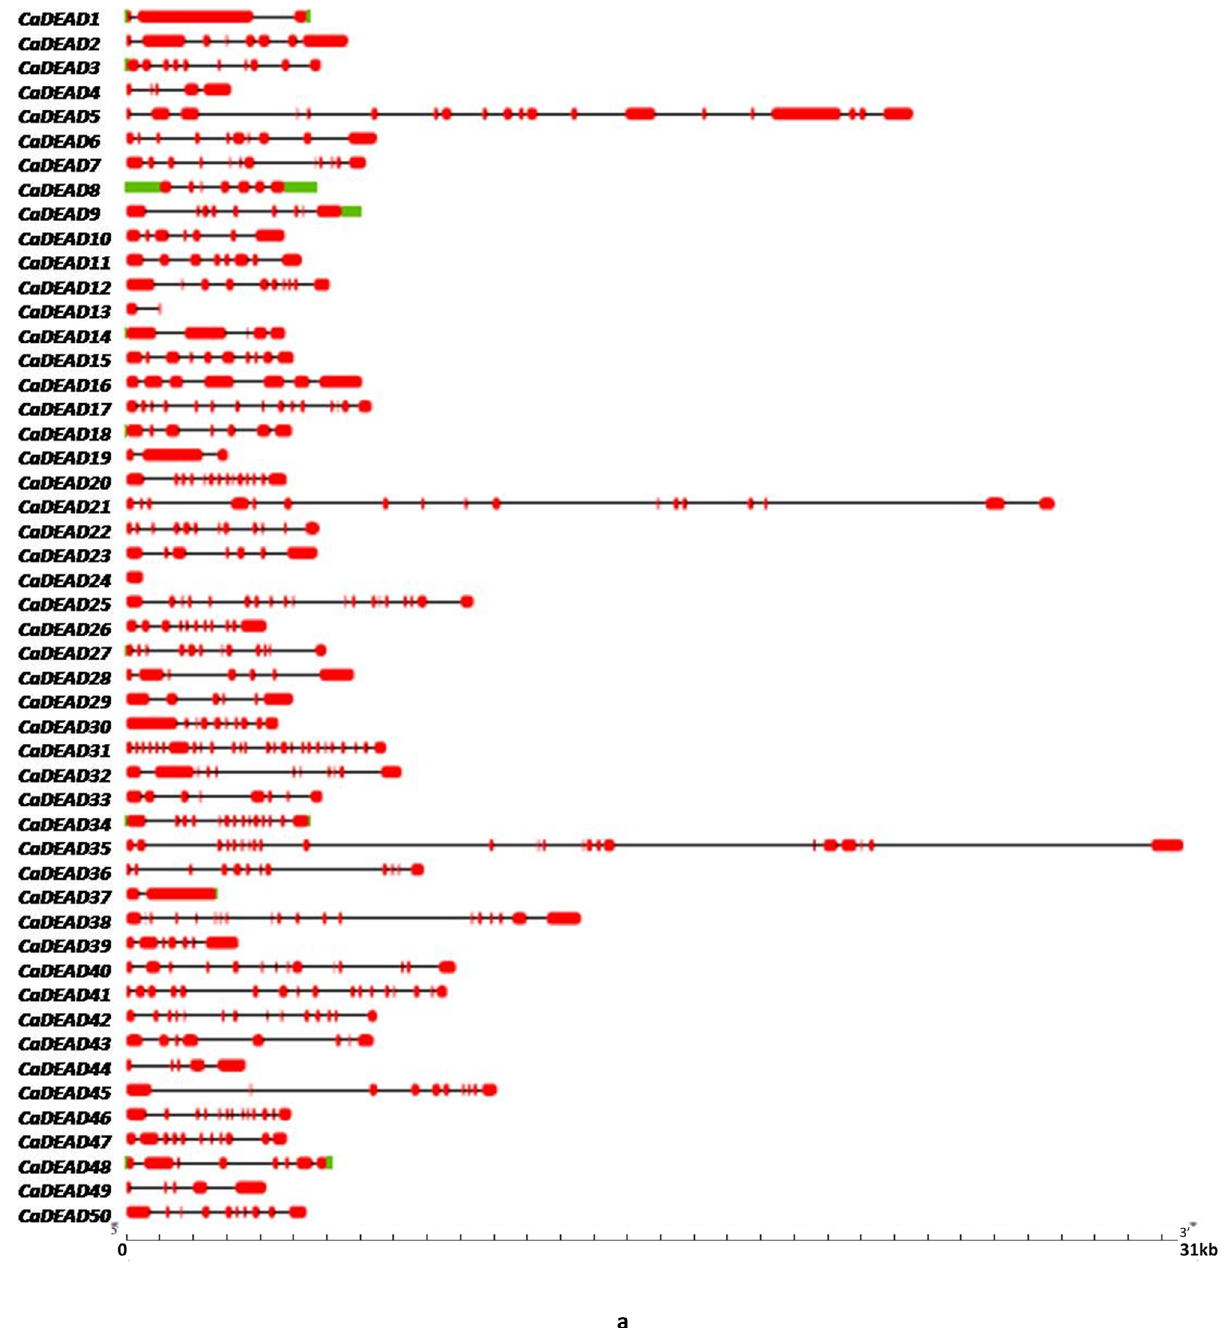
Figure 2. The gene structures depicting the exon–intron organization of the RNA helicase genes in chickpea. The scales at the bottom of each panel depict the gene lengths in Kilo bases (Kb). ( a ) The CaDEAD -box genes. ( b ) The CaDEAH -box genes. ( c ) The CaDExD/H- box